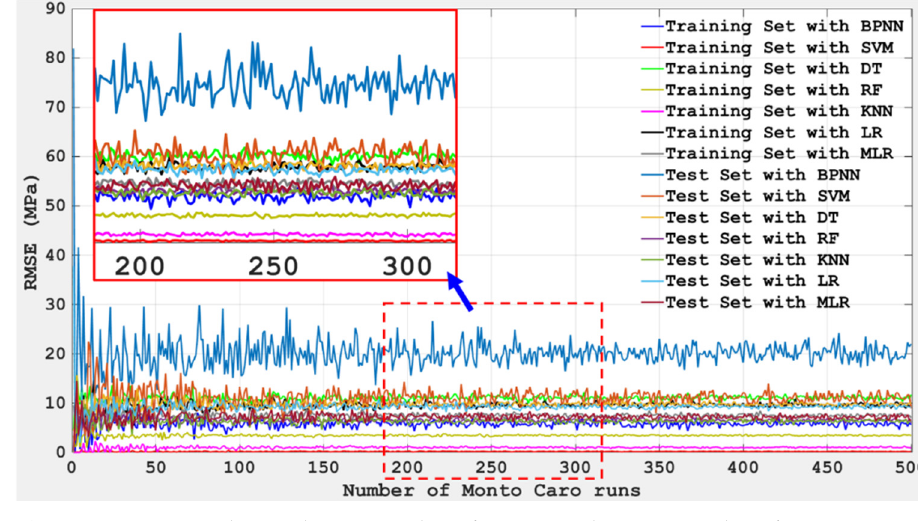
Figure 12. Monte Carlo simulation (number of Monto Carlo runs vs. value of RSME).